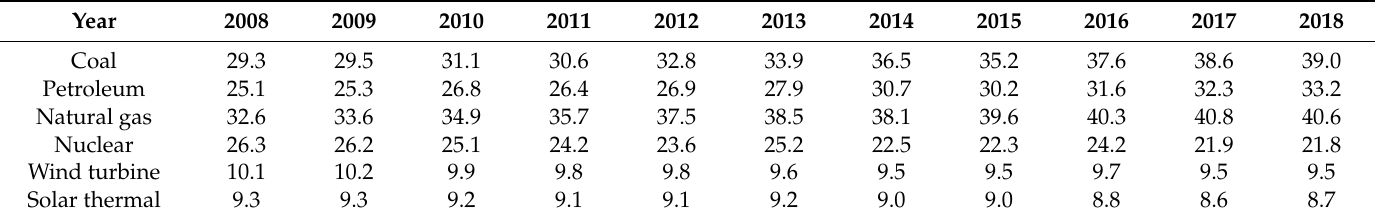
Table 5. Cost of energy (in USD) of di ff erent technologies per KWH.